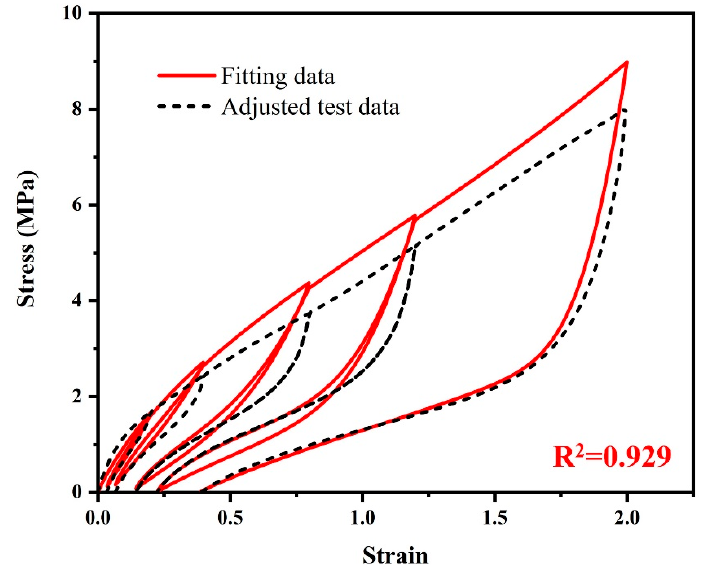
Figure 7. The comparison between the adjusted test data and the fitting data of the hyper-pseudo- viscoelastic model by using the initial material parameters in Table 1.